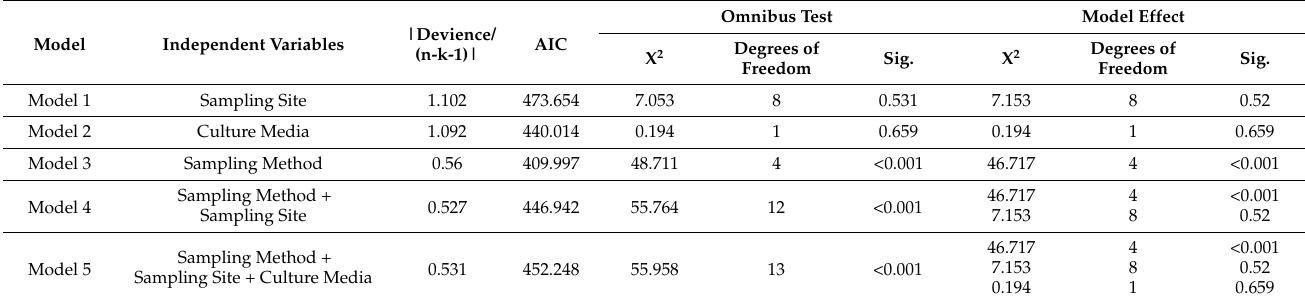
Table 4. Models Description: Identification of the Best Model.